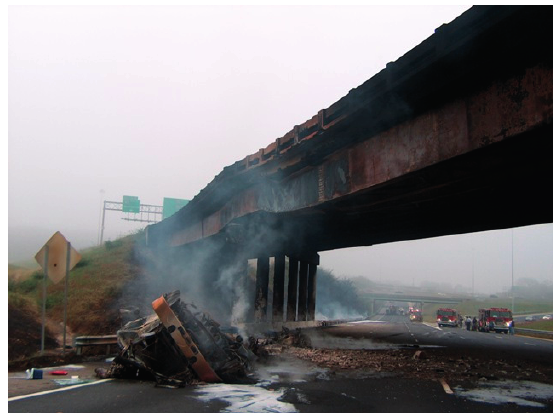
Figure 1. Visible bridge damage due to vehicular